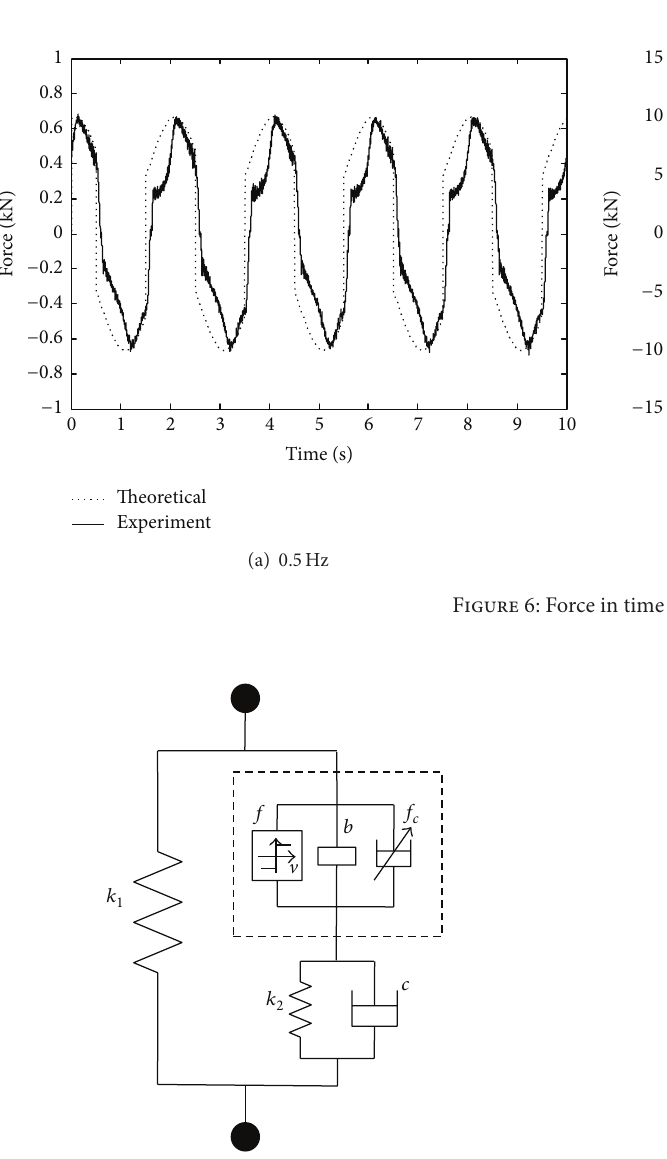
Figure 7: Nonlinear model of suspension